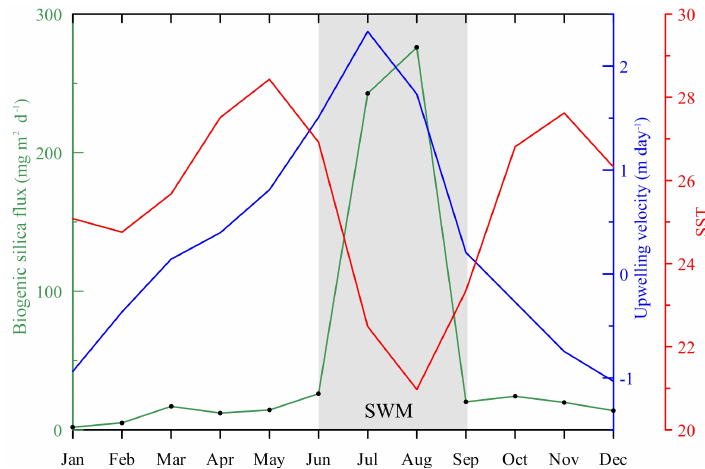
Figure 1. Modern oceanography of the western Arabian Sea. Synchronous changes in the upwelling intensity and biogenic silica flux clearly indicate that the siliceous productivity in the western Arabian Sea is controlled by SWM upwelling. Upwelling strength data are used from Yi et al. (2018) and biogenic silica flux data are used from Haake et al.